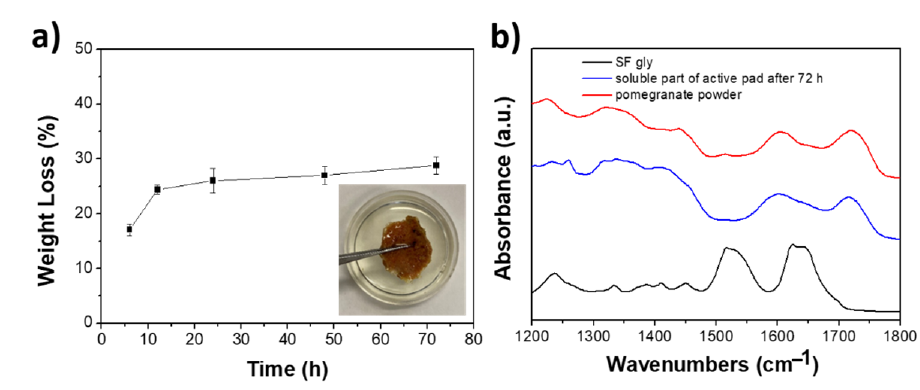
Figure 4. Weight loss in water of SF-pomegranate pad at different incubation times. Inset: picture of the SF-pomegranate pad after 72 h of incubation in water ( a ). Representative FTIR spectrum collected in amide regions (1200–1800 cm − 1 ) of the soluble part of active pad (blue line) compared with SF gly (black line) and pomegranate powder (red line) spectra ( b